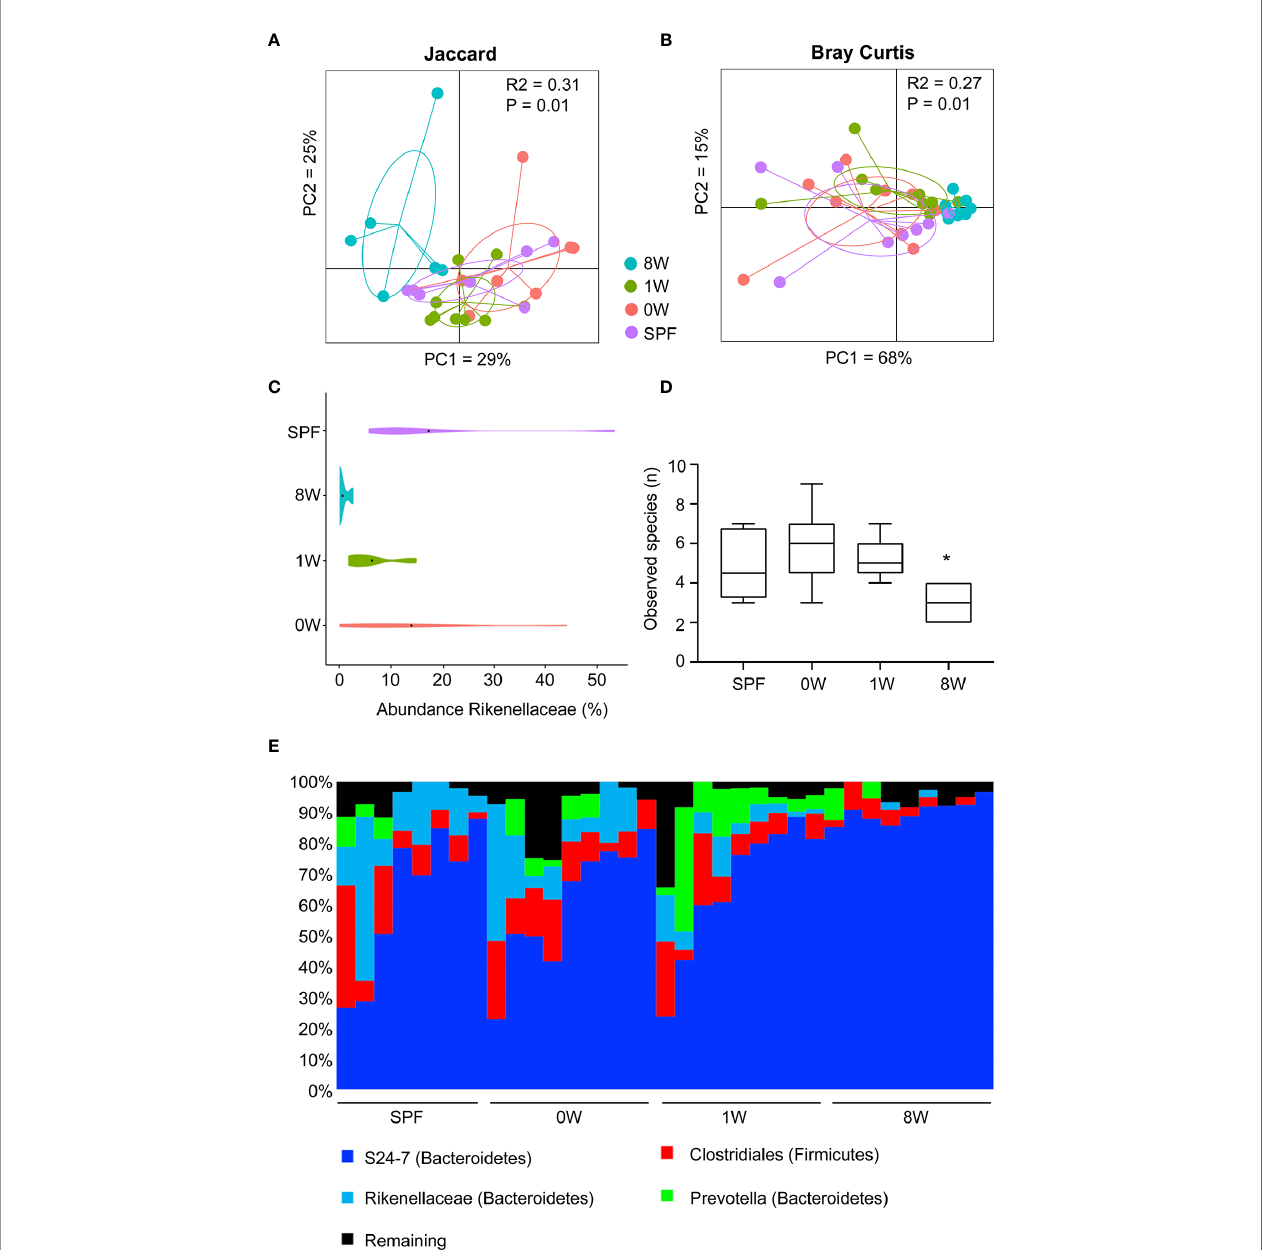
FIGURE 4 | Late colonization alters the gut microbiota composition. Principal coordinates analysis plot of nanopore based sequencing of the near full 16S rRNA gene amplicon based on (A) Jaccard (unweighted) and (B) Bray-Curtis (weighted) distance matrices as indicated. The plots illustrate feces samples from SPF ( n =8, purple), 0W ( n =9, red), 1W ( n =9, green) and 8W ( n =9, blue) mice before sensitization with oxazolone at 10 week-of-age. (C) Violin plot illustrating the abundance of the only taxa signi fi cantly different between the groups, the family Rikenellaceae. (D) Alpha diversity plot showing the observed species index based on species level summarized ASV table. (E) Chart illustrating the distribution of the main taxa colonizing the gut. * indicates p <